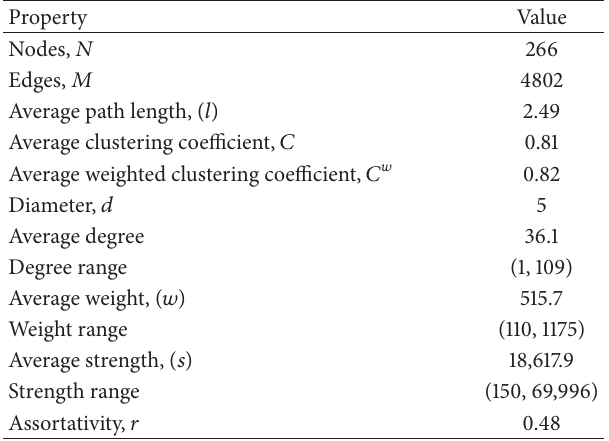
Table 1: Statistical properties of Pakistan national highway network.